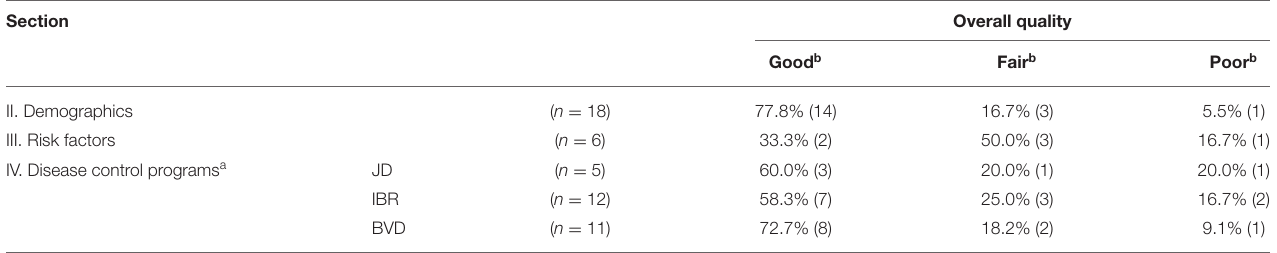
TABLE 2 | Results of the response to questions on overall quality of data relevant for estimating freedom from infection in cattle in an online questionnaire study among 24 European countries. Section